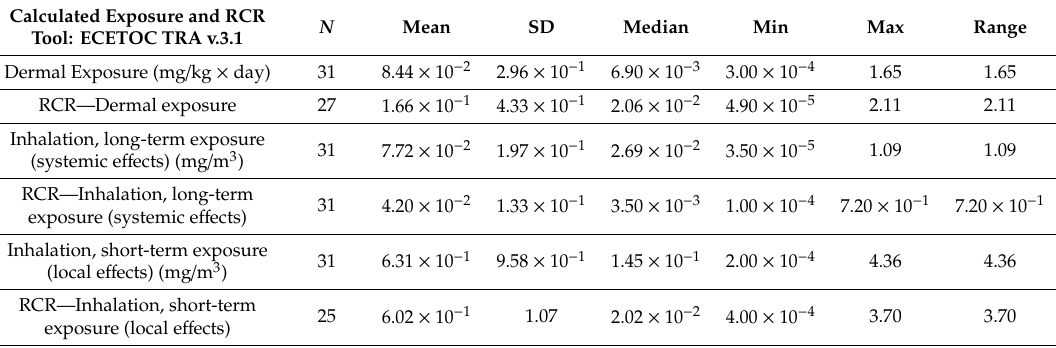
Table 6. Number of valid (N) exposure estimates calculated with ECETOC TRA v.3.1 model and associated RCRs for each route of exposure evaluated. SD: standard deviation; Min: minimum; Max: